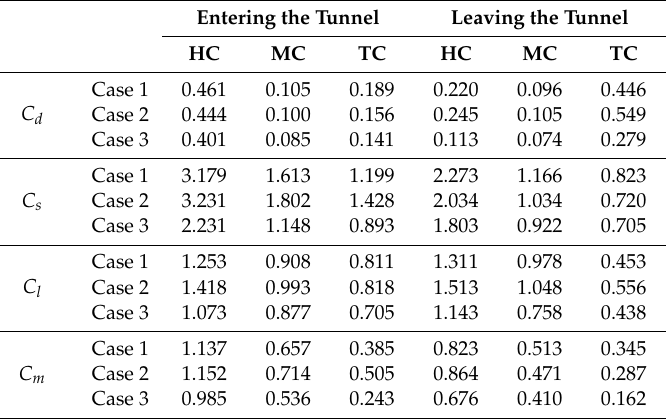
Table 4. Amplitude values of aerodynamic coe ffi